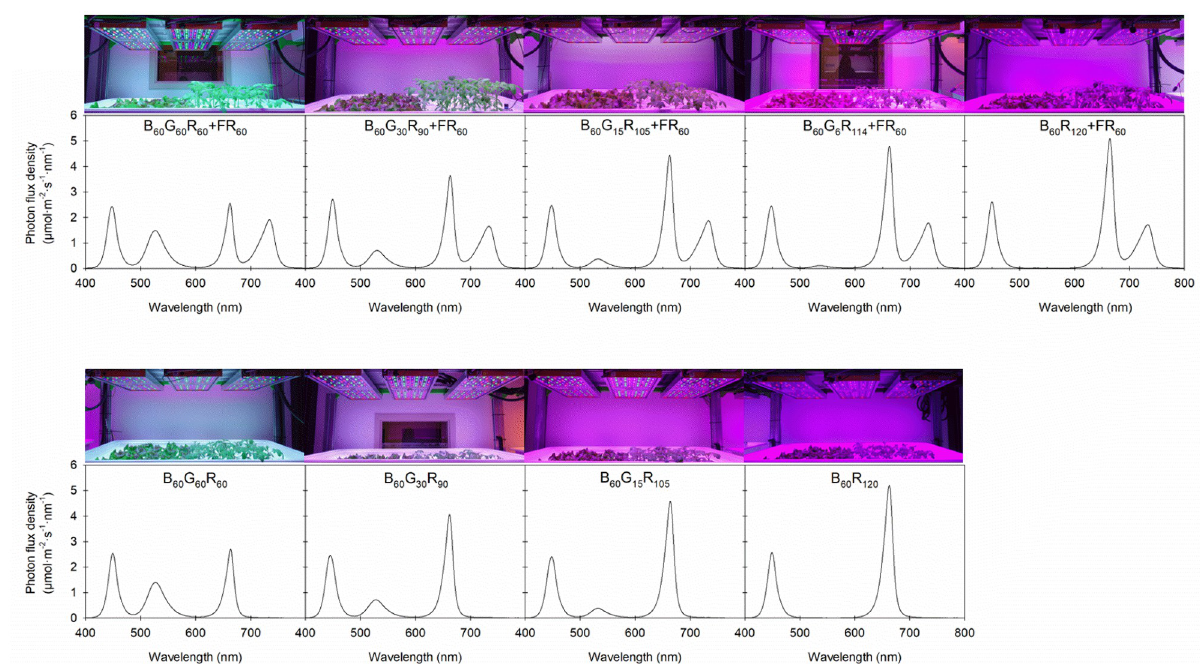
Fig 1. The spectra of nine lighting treatments. Lighting treatments consisted of blue (B, 400–500 nm), green (G, 500–600 nm), red (R, 600–700 nm), and far-red (FR, 700–800 nm) light delivered by light-emitting diodes. The value that follows each waveband indicates its photon flux density in μ mol � m − 2 � s − 1 .